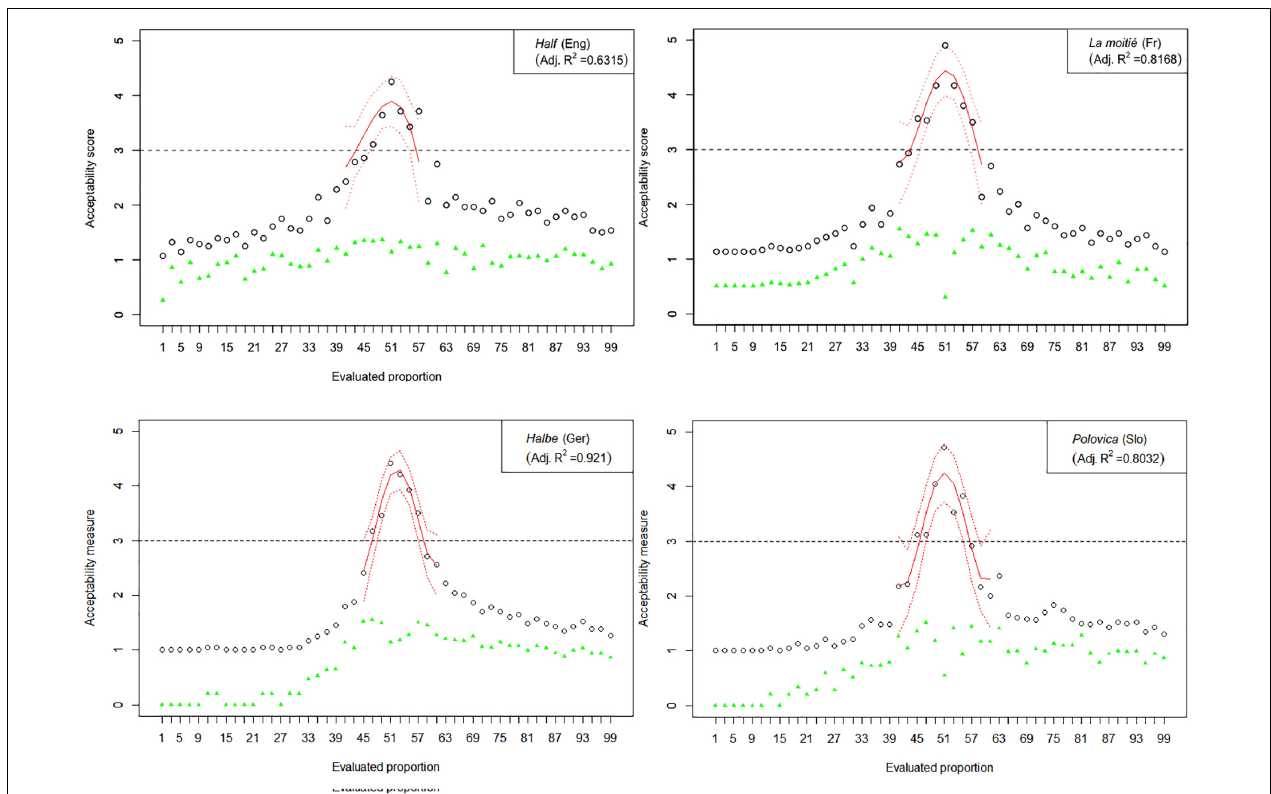
FIGURE 4 | Experiment 1: Mean acceptability scores on half and its cross-linguistic variants in the four tested languages (absolute values of standard deviation for respective means are shown in green), together with respective polynomial fit curves and confidence intervals predicting acceptability in the upper half of the Likert